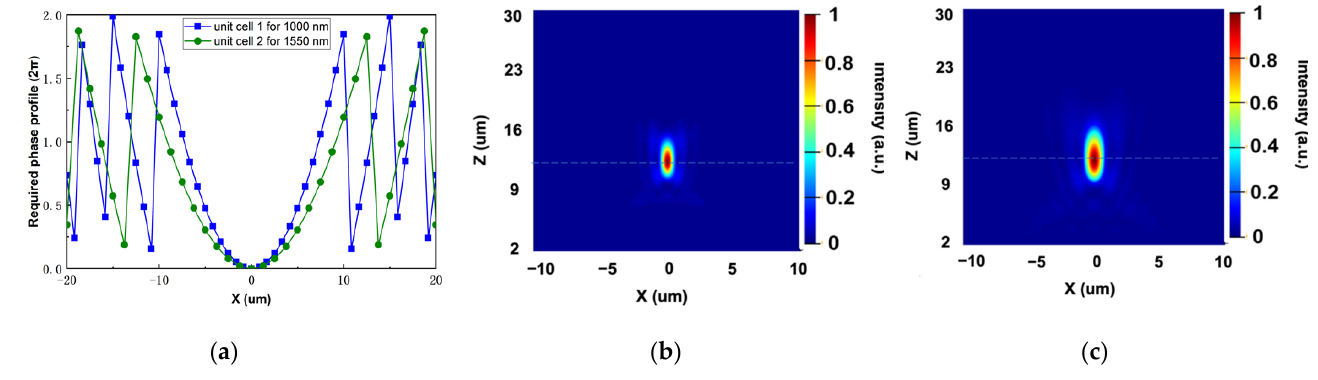
Figure 3. ( a ) The required phase profiles for the general single focus metalens under the illumination of 1000 and 1550 nm. ( b , c ) The normalized optical intensity of the x–z plane at y = 0 with the incident at the wavelength of 1000 nm ( b ) and 1550 nm ( c ).